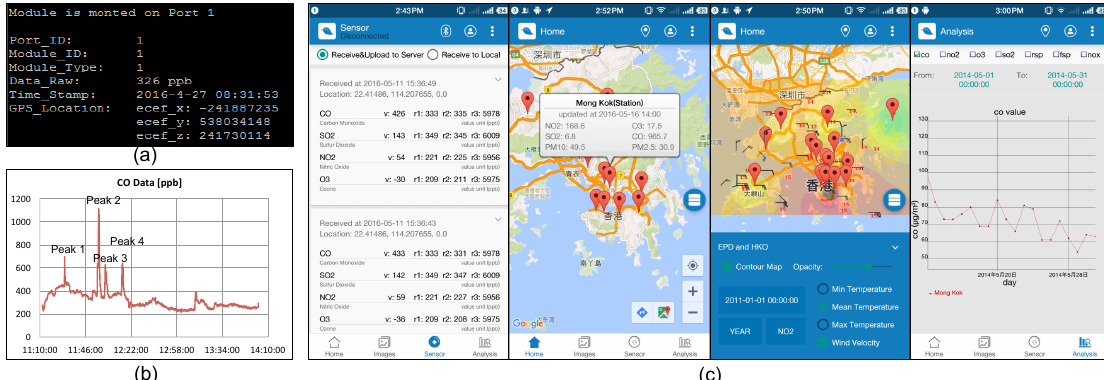
Figure 5. ( a ) raw data from the MSS sensor node through USB Port; ( b ) CO concentration over time (data were collected from 11:11:40 to 14:02:30 on 27 April 2016. The four labeled peaks accompanied the